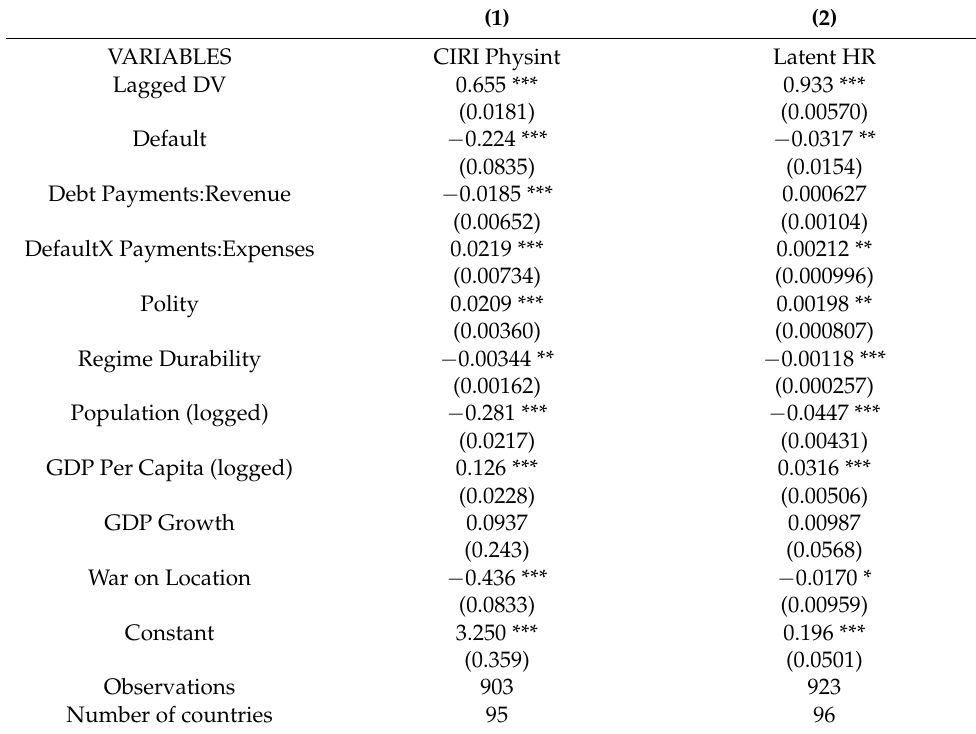
Table 3. Default x Debt to Expenses and Physical Integrity